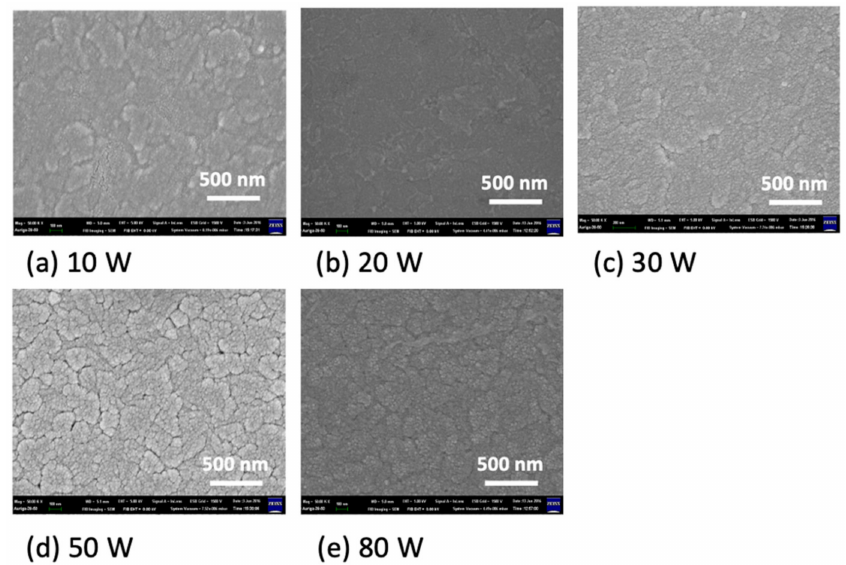
Figure 4. The surface morphology of the Ni-V-O film by FE-SEM with respect to different powers toward the Ni target ( a ) 10 W, ( b ) 20 W, ( c ) 30 W, ( d ) 50 W, and ( e ) 80 W, respectively.